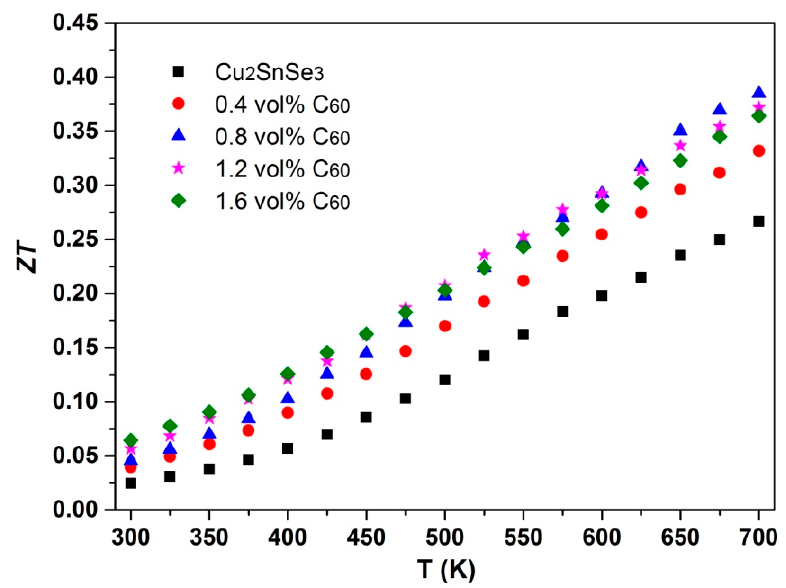
Figure 11. Temperature dependence of the dimensionless figure of merit of ( ZT ) of C 60 /Cu 2 SnSe 3 composites.